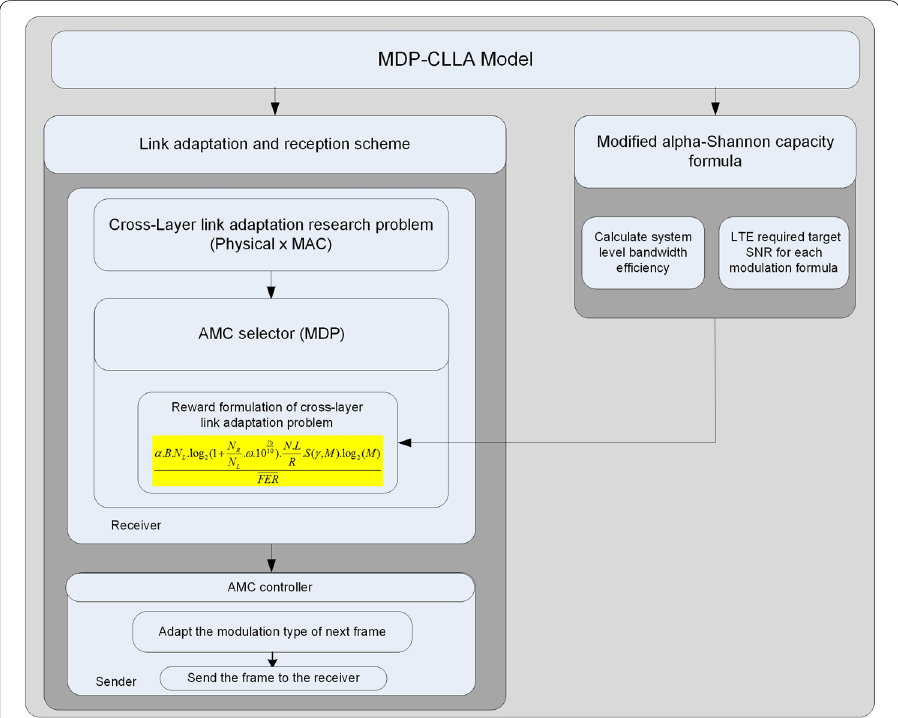
Fig. 3 Proposed MDP‑CLLA optimization